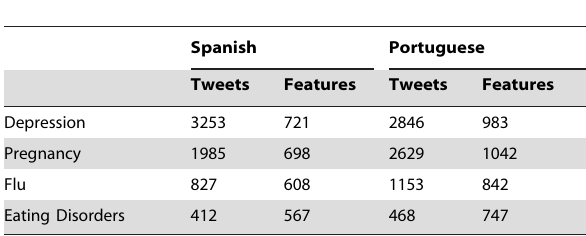
Table 3. Number of examples and features in each